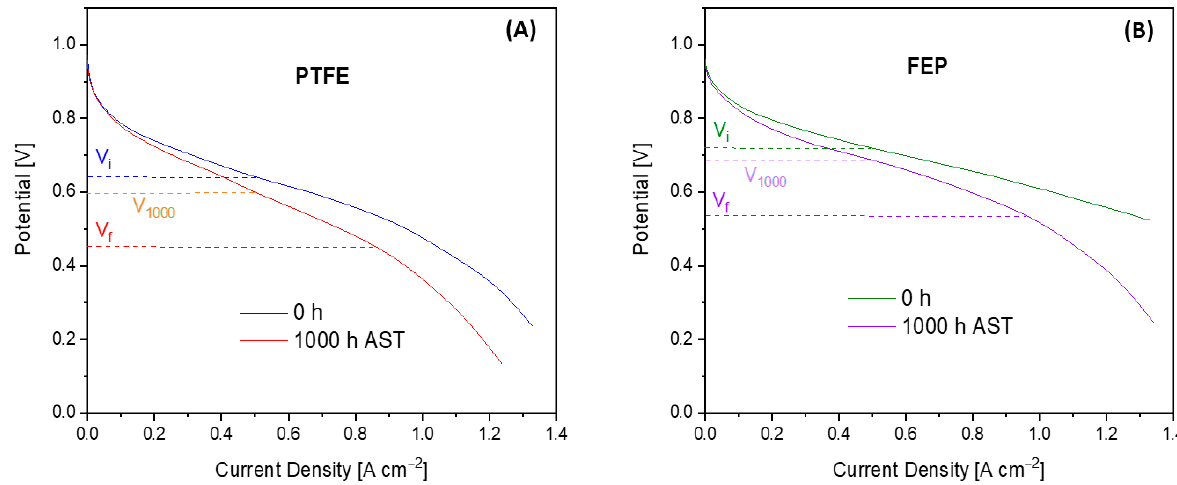
Figure 1. Polarization curves of the single cell assembled with fresh (0 h) and stressed (1000 h AST) PTFE- ( A ) or FEP-based ( B ) GDMs. AST: accelerated stress test.